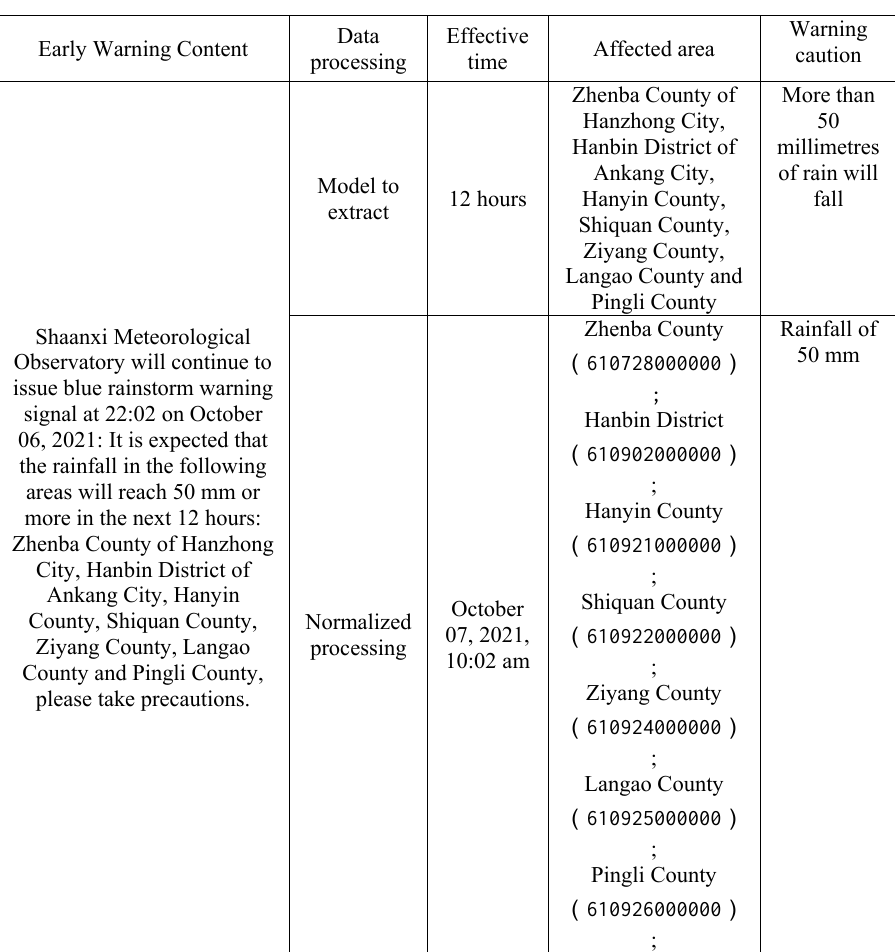
Table 2. Extraction results of application